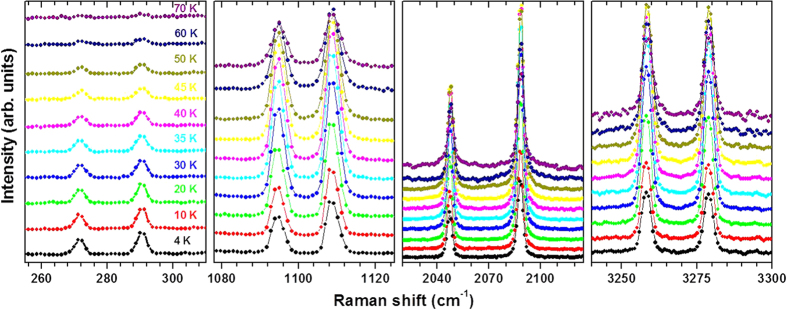
Raman spectra of the LaAlO3 as a function of temperature. The peaks get weaker at higher temperatures.